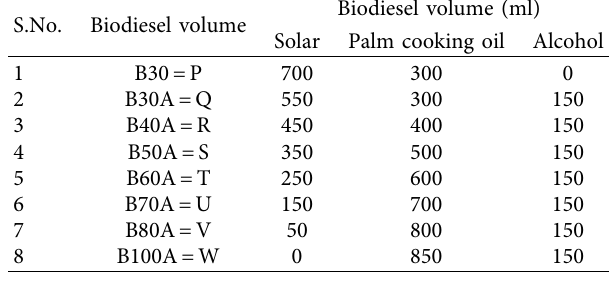
Table 2: Biodiesel formulation.